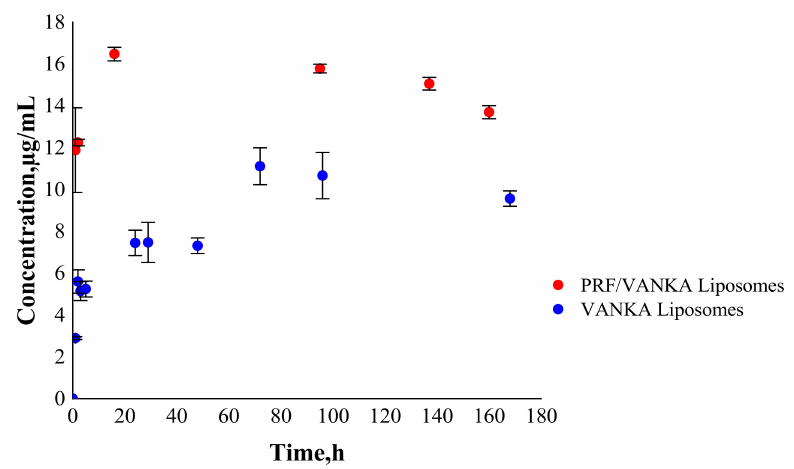
Figure 10. Drug release from PRF/VANKA liposomes and VANKA